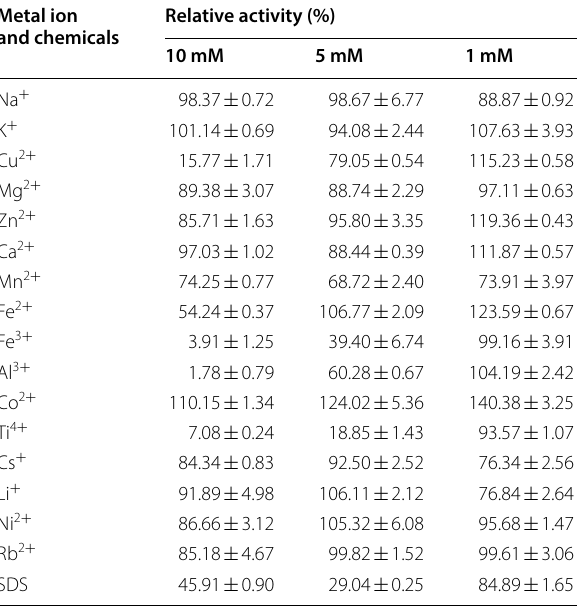
Table 1 Effect of metal ions and chemical on the cellulase activity of Cel-A5